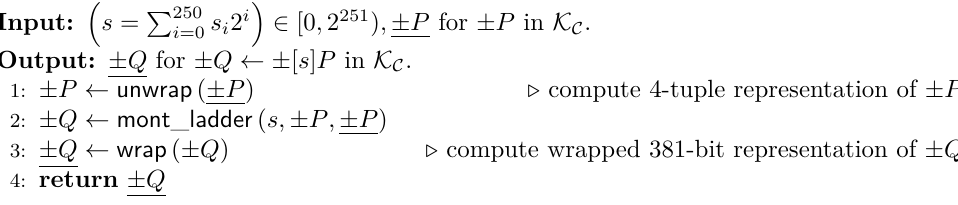
Algorithm 1 scalar _ mult : unwrap input point to Montgomery ladder on K C followed by point wrapping. It is assumed that the public key (respectively public generator) is in 381-bit wrapped